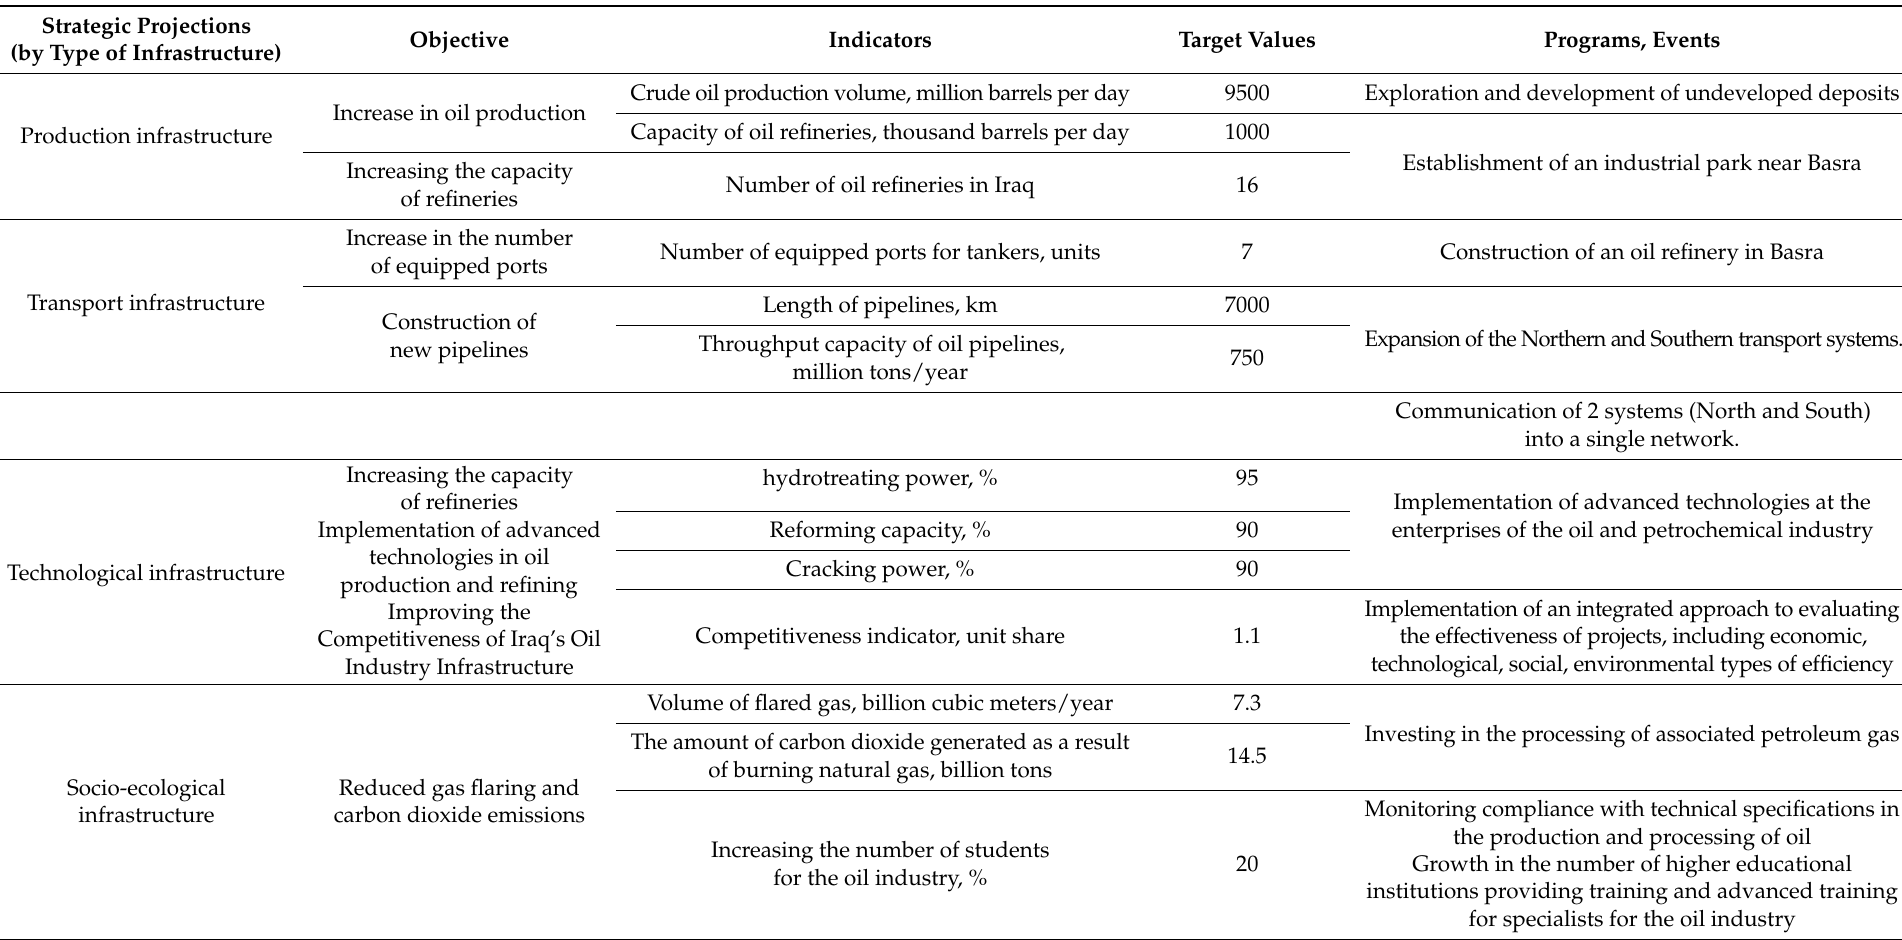
Table 8. Iraqi Oil Infrastructure’s Strategic Development Scorecard Summary